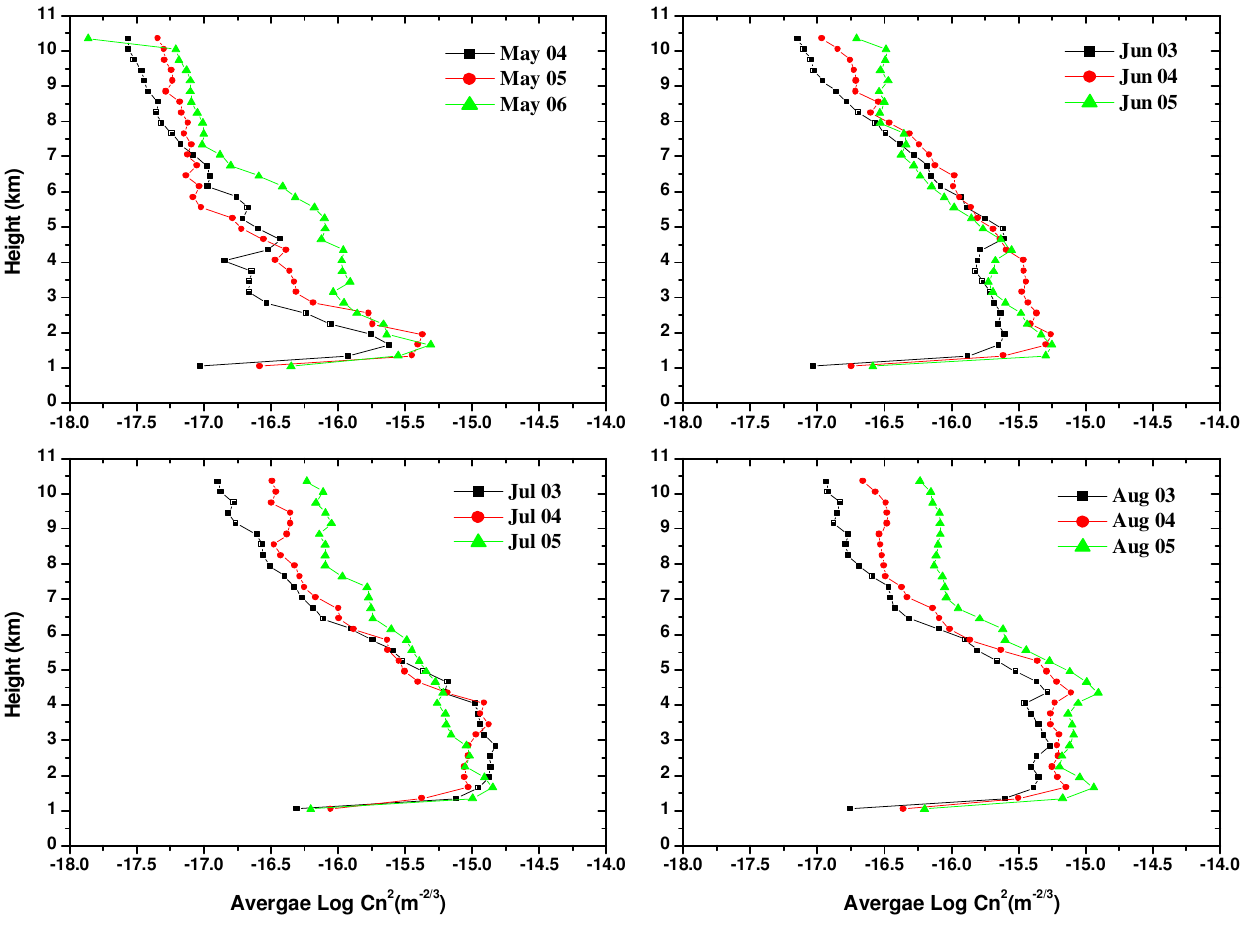
Fig. 10. Height profile of mean Log C 2 n showing inter-annual features for the months of May, June, July and